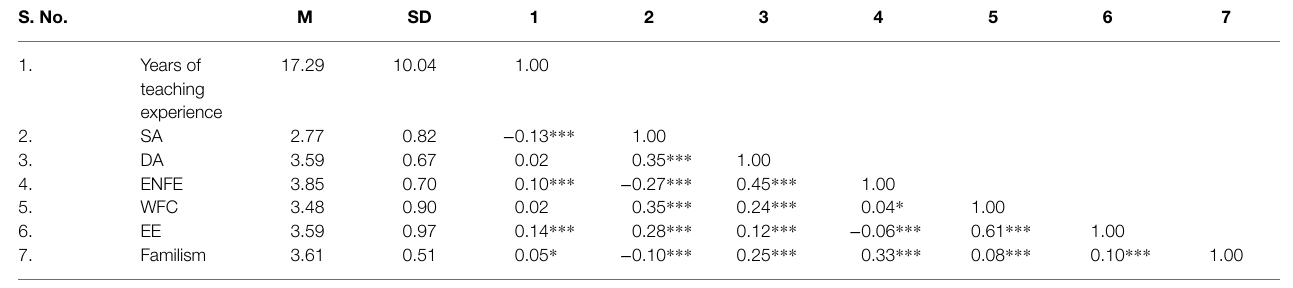
TABLE 2 | Descriptive statistics and correlations for the variables in this study.